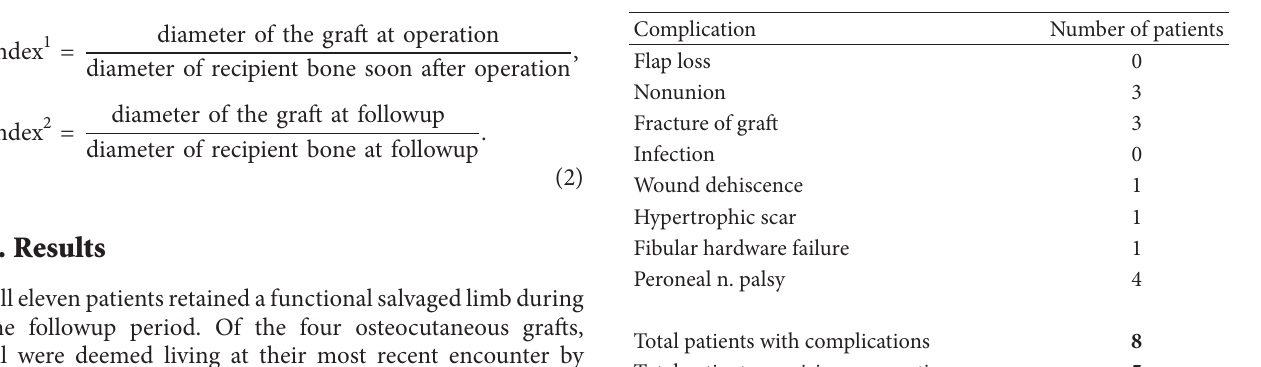
Table 2: Summary of